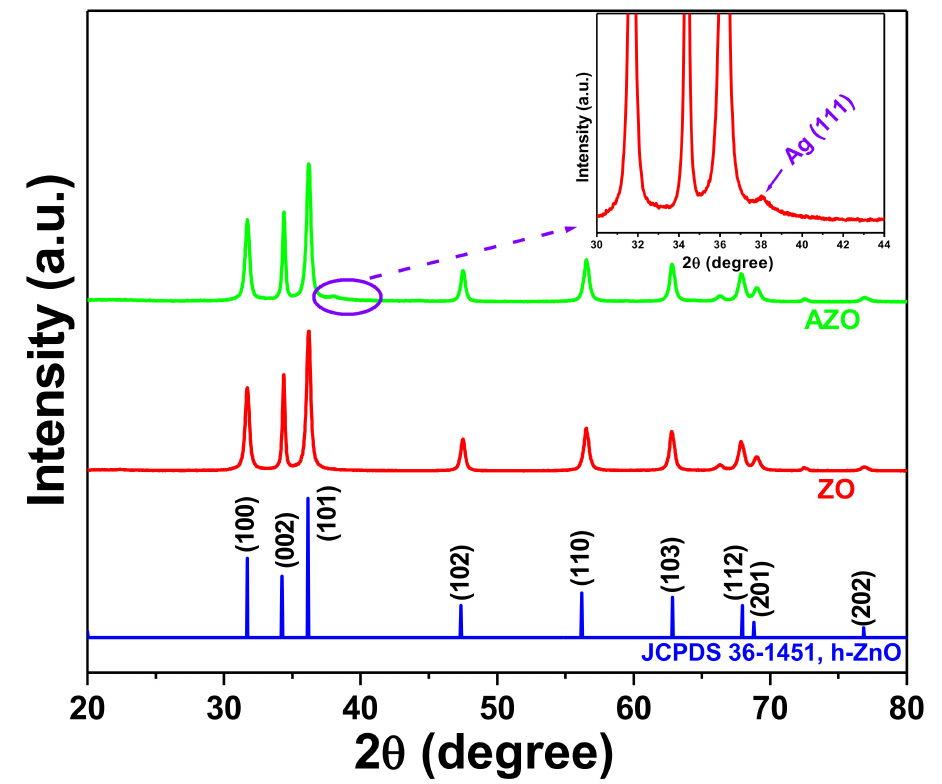
Figure 1. X-ray di ff raction patterns of ZO and AZO samples. Inset shows the enlarged spectra (marked portion) of the AZO